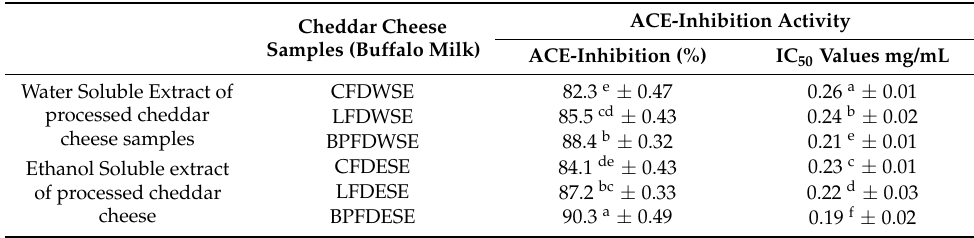
Table 2. ACE inhibitory activity is expressed as IC 50 value (as the amount of protein content needed to inhibit 50% of the ACE inhibitors).